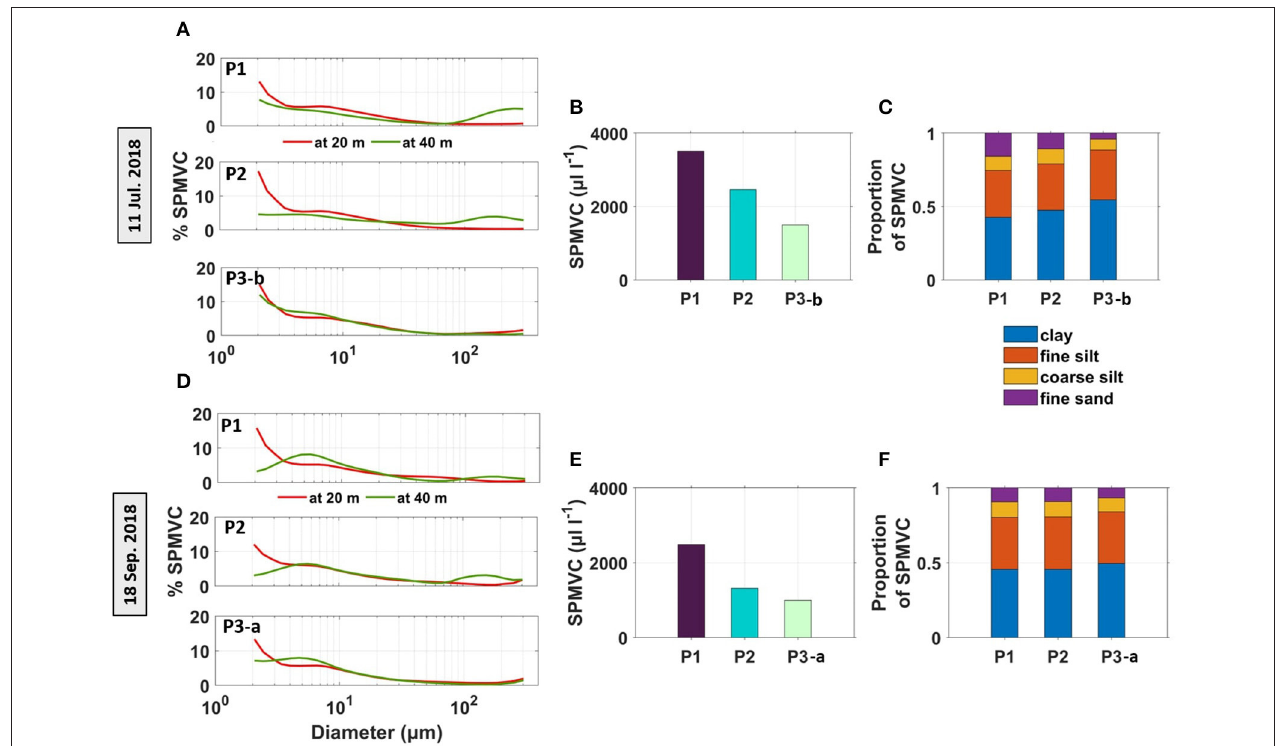
FIGURE 8 | Depth-averaged Particle Size Distribution (PSD) (% of total particle volume (SPMVC) for size classes in µ m) measured at (A) stations P1, P2, P3-b on 11 July 2018 and at (D) P1, P2, P3-a on 18 September 2018. The red and green lines represent the PSD at 20 and 40m (averaged over 1-m depth). (B,E) Total SPMVC computed at P1, P2, P3-a, P3-b, and (C,F) proportions of clay, fine silt, coarse silt and fine sand in terms of proportion of total SPMVC averaged over the water column, at P1, P2 and P3-a, P3-b during the two campaigns. For station locations, (see Figure 1B ).